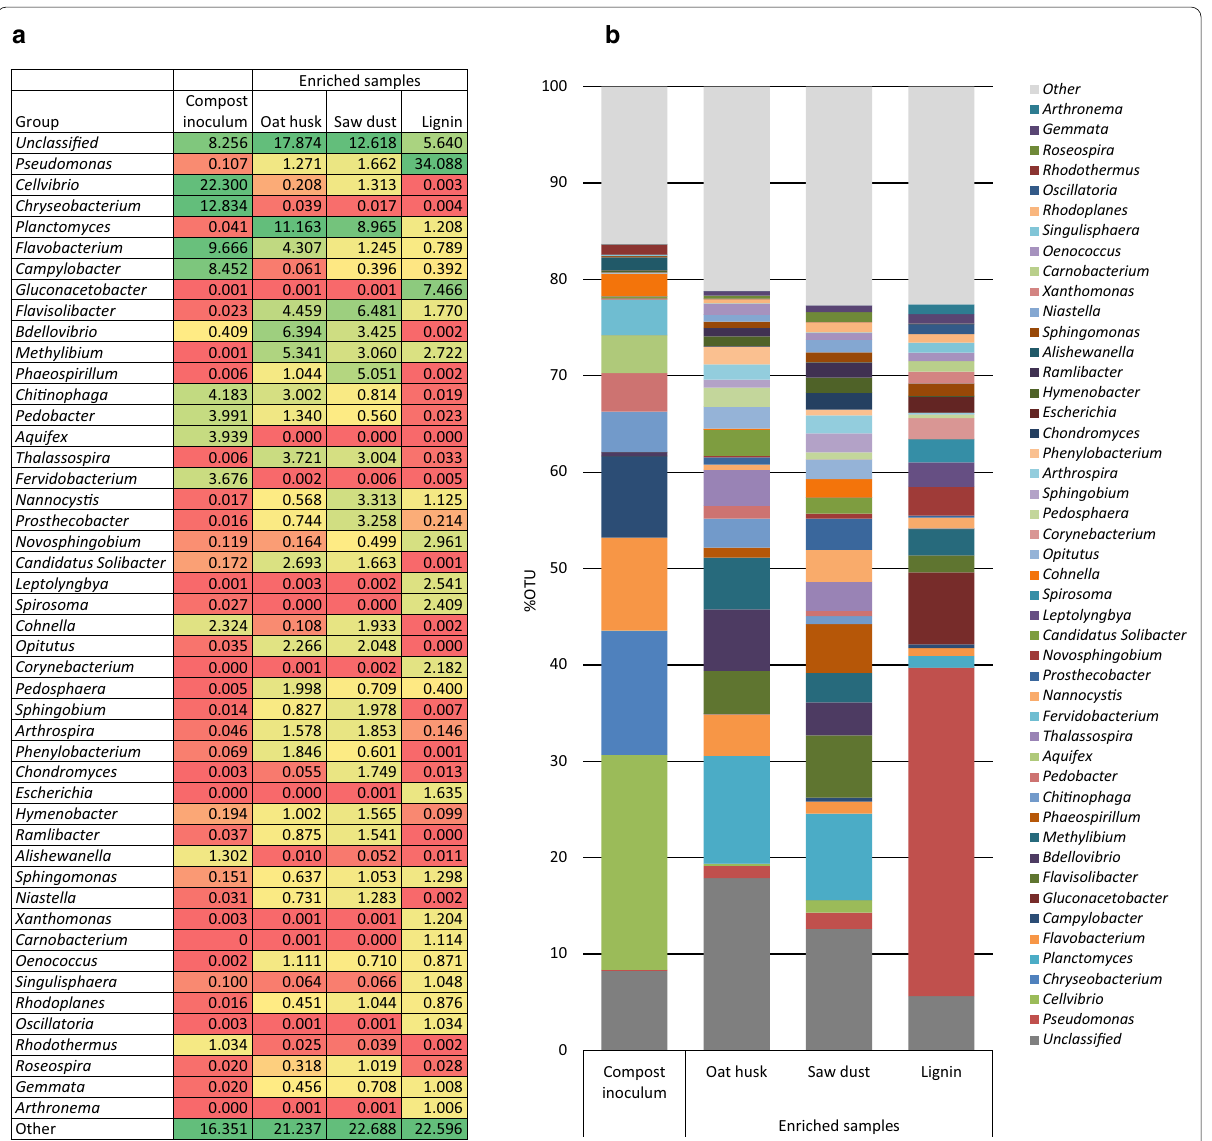
Fig. 4 Bacterial consortium composition (genus level) in compost samples as analysed by 16S rRNA amplicon sequencing after enrichment using 3 different substrates (oat husk, pine saw dust, lignin) at 30 °C for 20 days, compared with the compost inoculum. a Heat map presenting the abundancy of dominating genera. b Consortium composition of the most dominating genera in inoculum sample as well as after enrichment. “Other” is the sum of all classified genera with individual abundancies below 1% in all samples. “Unclassified” includes sequences classified at higher taxonomic levels, but where no genus information could be